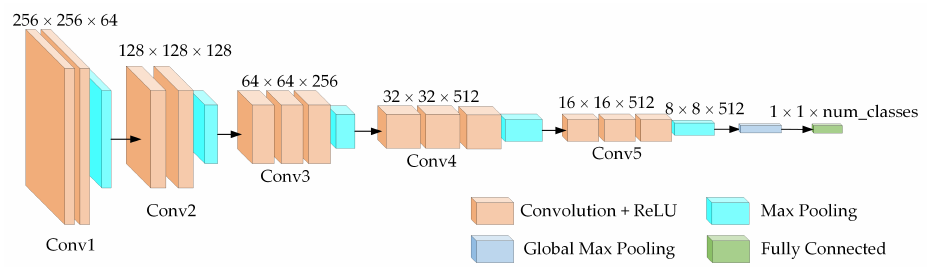
Figure 2. Structural overview of the improved VGG16